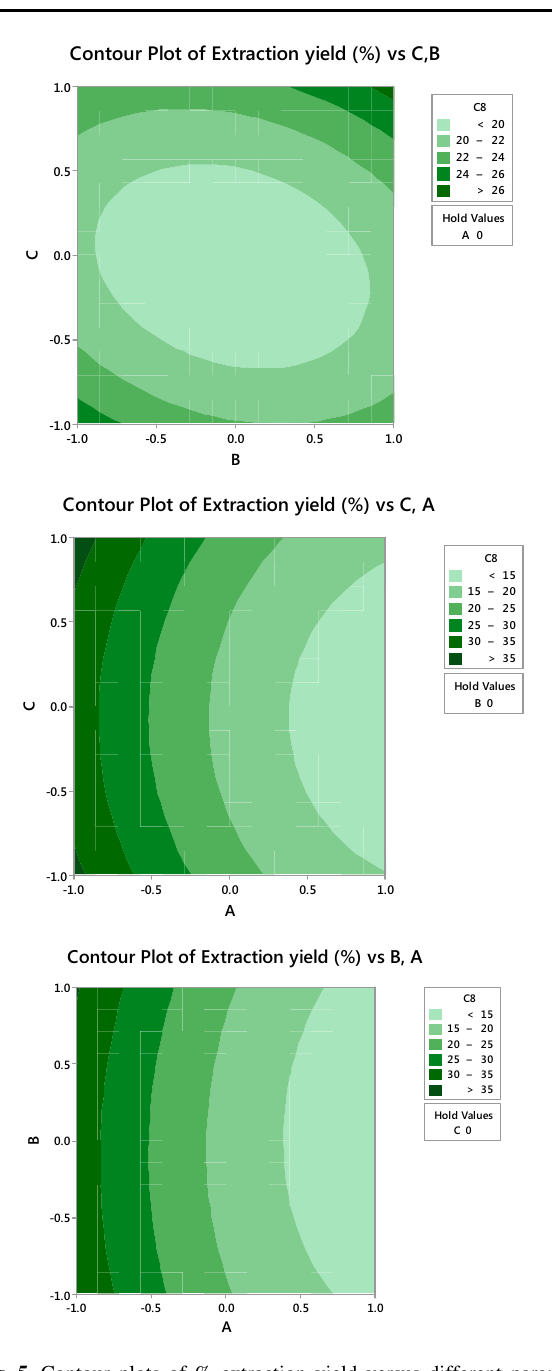
Fig. 5 Contour plots of % extraction yield versus different param- eters (A: particle size, B: % co-solvent in solvent, C: total amount